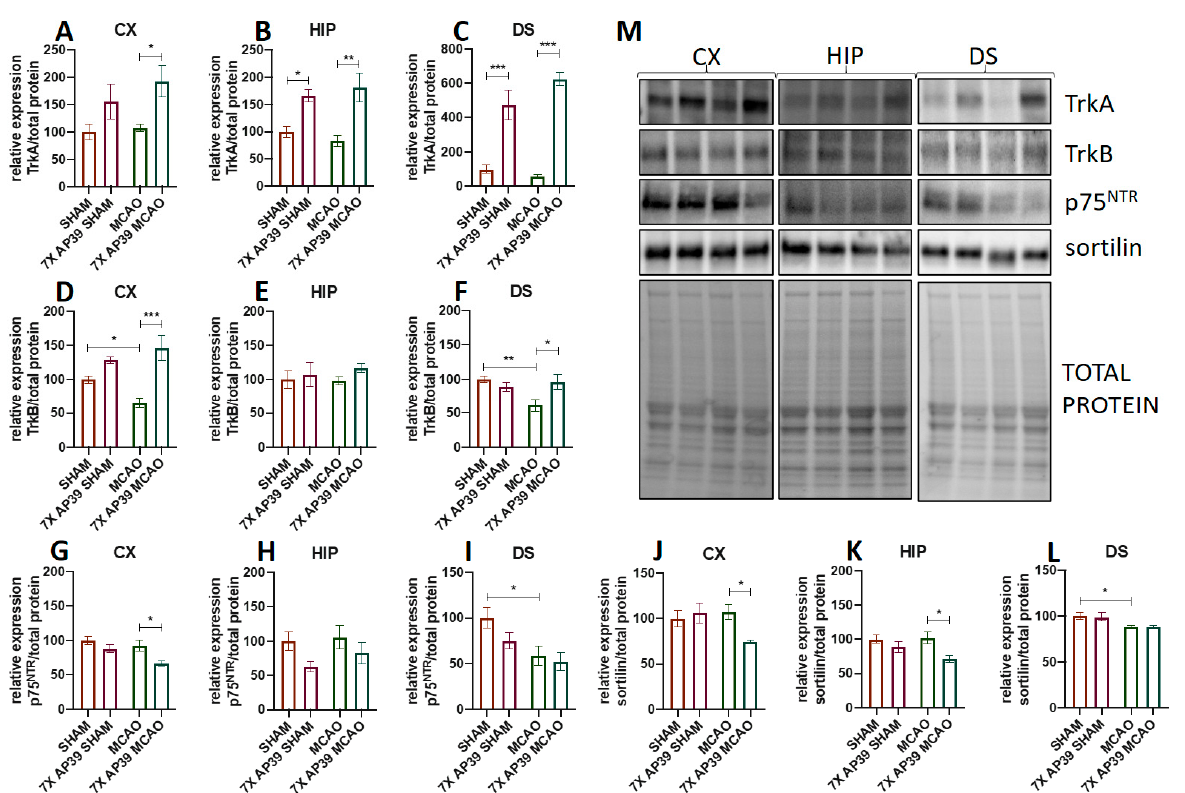
Figure 8. The effect of MCAO and AP39 on the protein expression levels of crucial growth factor receptors. ( A – C ) The protein expression level of TrkA in the frontal cortex (CX), the hippocampus (HIP) and in the dorsal striatum (DS), respectively. ( D – F ) The protein expression level of TrkB in the CX, HIP and in the DS, respectively. ( G – I ) The protein expression level of p75 NTR in the CX, HIP and in the DS, respectively. ( J – L ) The protein expression level of sortilin in the CX, HIP and in the DS, respectively. ( M ) Immunoblots representative for the CX, HIP and DS for TrkA, TrkB, p75 NTR and for sortilin, together with the total protein amount visualized by the stain-free technique. The order of the samples is the same as in the graphs. n = 6, one-way ANOVA, followed by Sidak’s correction for post hoc comparisons; * p < 0.05, ** p < 0.01 and *** p < 0.001 vs. MCAO or SHAM. Data are presented as the mean ± SEM.